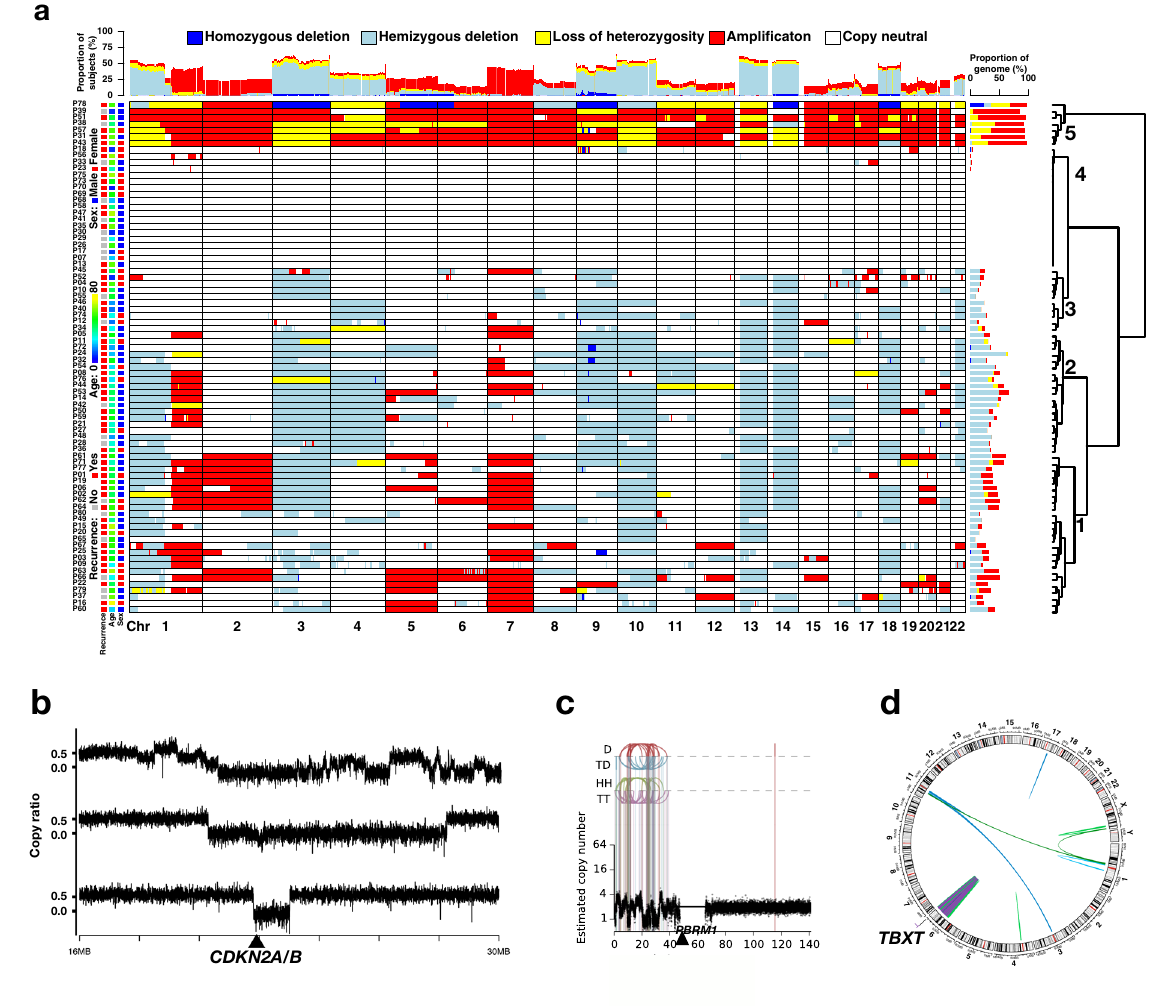
Fig. 3 Somatic copy number alterations (SCNAs) and structural variants (SVs) in skull-base chordoma patients. a Genome-wide SCNAs. Patients were clustered into fi ve groups. Group 1: extensive SCNAs, lacking deletions of 4, 9, and 14; Group 2: extensive SCNAs, lacking ampli fi cations; Group 3: scattered SCNAs, most of which are deletions; Group 4: no or few SCNAs; and Group 5: extensive ampli fi cations demonstrating characteristic consistent with whole- genome doubling. b Representative examples showing complex rearrangements at chromosome 9p. Plots show copy ratios (tumor vs. matched normal) of the chromosome 9p21 region. All three samples show an arm-level deletion coupled with complex rearrangements (top) and focal deletions of the 9p21.3 region (middle) or the CDKN2A/2B locus (bottom), resulting in the homozygous loss of CDKN2A/2B . c An example of complex rearrangements at chromosome 3p. D deletion, TD tandem duplication, HH head-to-head inverted, TT tail-to-tail inverted. d A chordoma sample showing chromothripsis of the 6q region, where the TBXT gene is located. See also Supplementary Tables 4 and